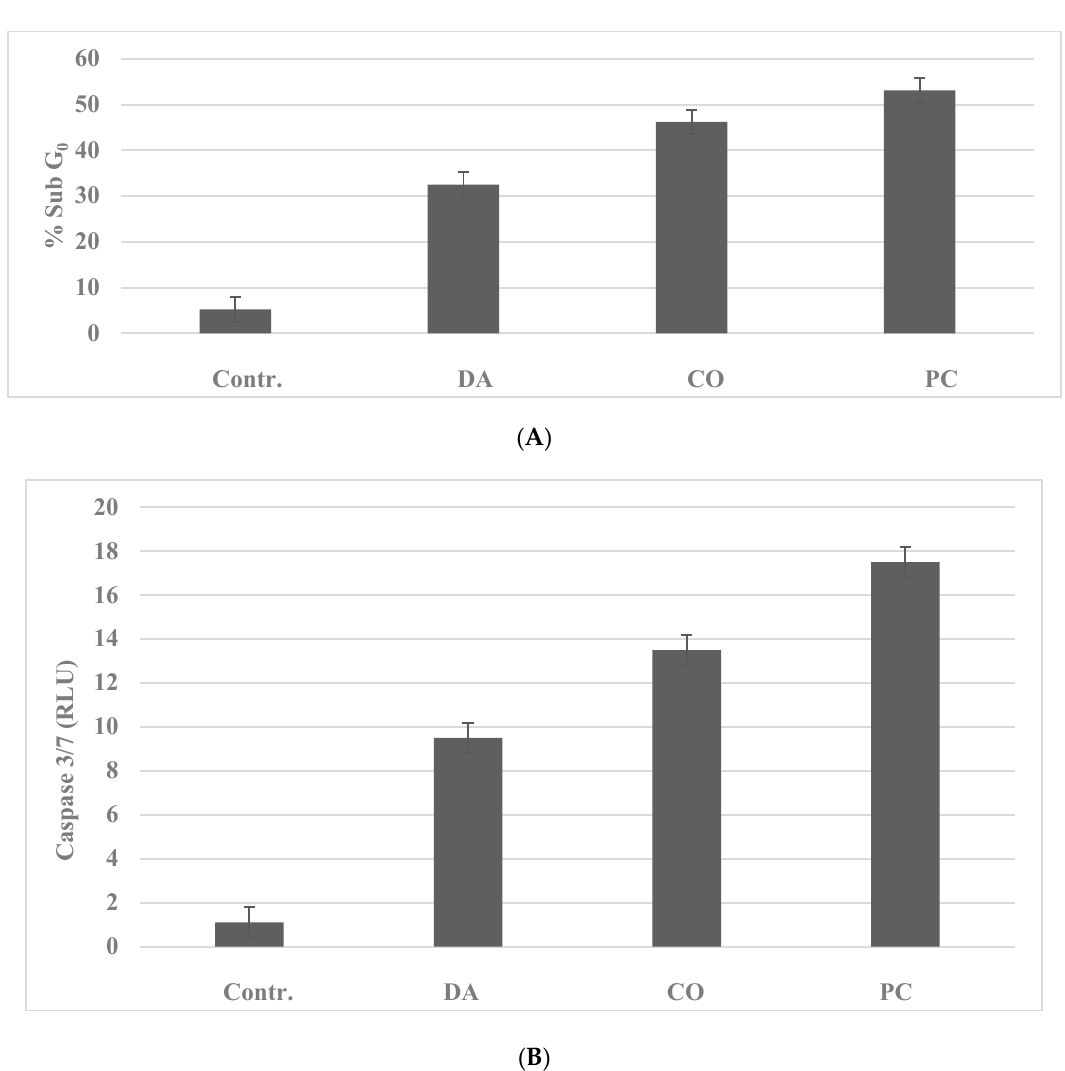
Figure 5. ( A ): Effect of Chinese herbs on cellular apoptosis. Treatment with DA, CO and PC at their respective IC 90 doses increased % sub G 0 population. The data are presented as % sub G 0 population mean ± SD, n = 3 per treatment group. ( B ): Effect of Chinese herbs on Caspase 3/7 activity. Treatment with DA, CO and PC at their respective IC 90 doses increased caspase 3/7 activity. The data are presented as RLU mean ± SD, n = 3 per treatment group. The data are analyzed by ANOVA with Dunnett’s multiple comparison test. ( α = 0.05). Contr.; control; DA, Dipsacus asperoides; CO, Cornus officinalis; PC, Psoralea corylifolia; RLU, relative luminescent unit; SD, standard deviation; ANOVA, analysis of variance. Data summarized from [14–16].